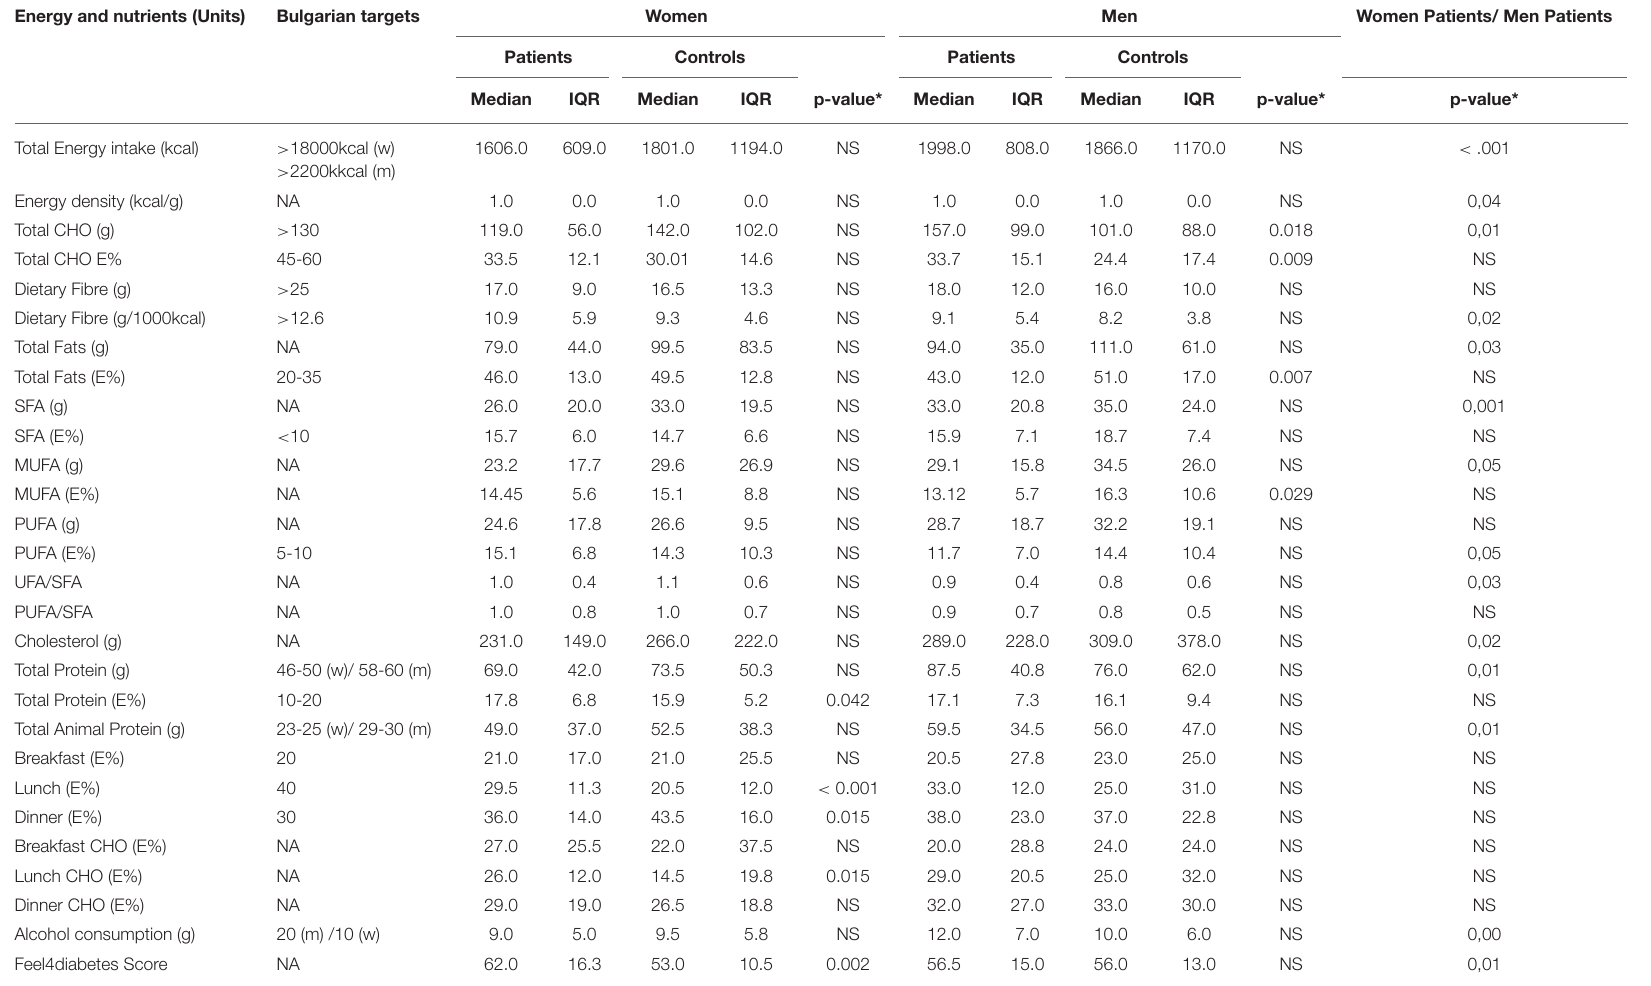
TABLE 2 | Intake of energy and nutrients per day in T1D patients with long disease duration compared to healthy age and gender matched controls. Energy and nutrients